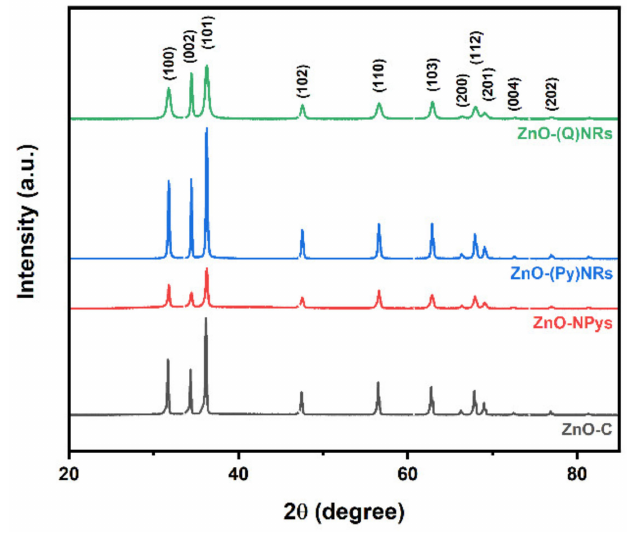
Figure 3. XRD patterns of pristine ZnO-(Q)NRs, ZnO-(Py)NRs, ZnO-NPys, and